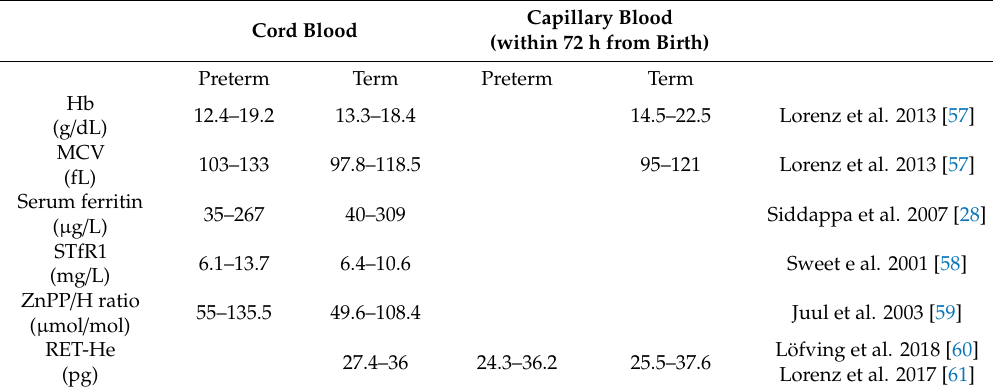
Table 2. Reference ranges for the main iron status parameters in term and preterm neonates. Cord